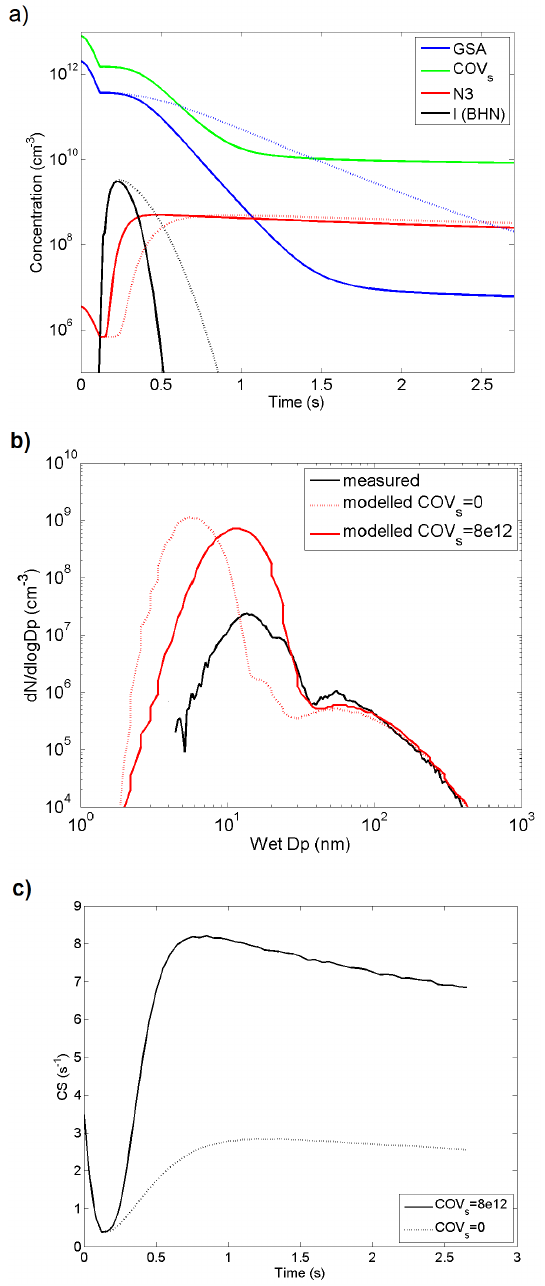
Figure 3. (a) Time evolution of particle number concentration (N 3 ) , gaseous sulfuric acid (GSA) and condensable organic vapour (COV s ) in cm − 3 , as well as nucleation rate ( I ) incm − 3 s − 1 by the BHN mechanism. Solid lines refer to COV s = 8 × 10 12 cm − 3 and dashed lines to COVs = 0. (b) Measured (black) and mod- elled (red) particle number size distribution at the end of the ageing chamber. (c) Condensation sink for sulfuric acid. Initial GSA = 2 × 10 12 cm − 3 , COV s = 8 × 10 12 cm − 3 and COV s = 0.